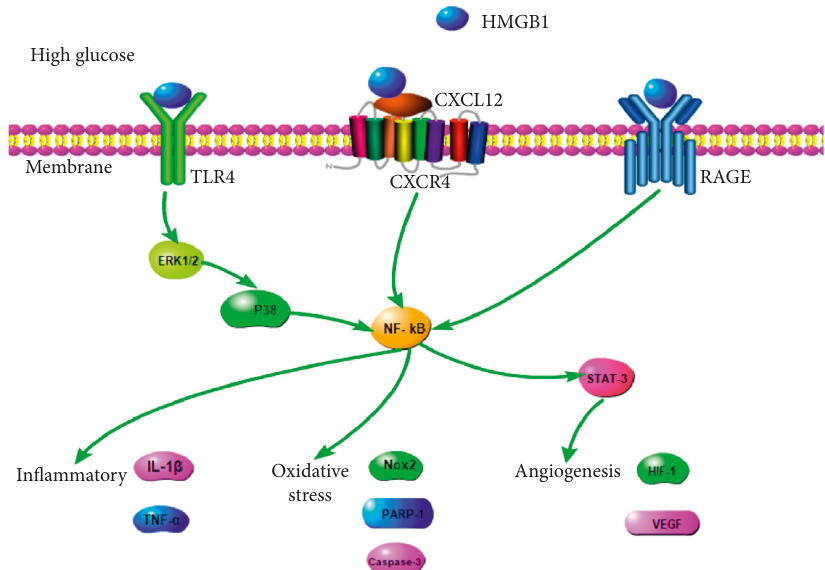
Figure 1: HMGB1 signal by binding to TLR4, CXCR4, and RAGE to moderate BV2 cells, RGC cells, retinal endothelial cells, and retinal microvascular endothelial cells function in PDR. In these cells, HMGB1 binds TLR4 and activates ERK1/2-P38-NF- κ B signal pathway. HMGB1 also binds RAGE and upregulated the expression of NF- κ B. In human retinal microvascular endothelial cells, HMGB1 binds CXCR4 to activate NF- κ B/STAT-3 signal pathway. These three signaling has been implicated in cell inflammatory, oxidative stress, and